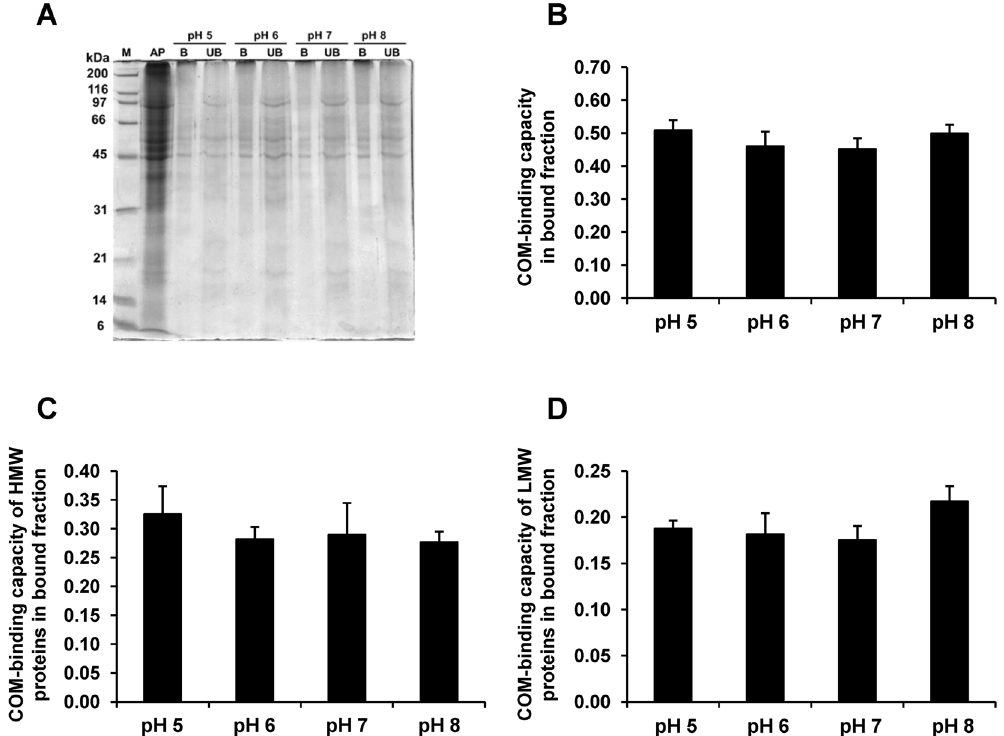
Figure 7. Effect of pH on COM-binding capacity of apical membrane proteins. Proteins isolated from apical membranes of polarized MDCK cells were incubated with plain COM crystals under varying pH conditions. ( A ) SDS-PAGE band patterns of apical membrane (AP), bound (B) and unbound (UB) fractions stained with Coomassie Brilliant Blue G-250. ( B ) COM-binding capacity of proteins in the bound fraction. ( C ) COM- binding capacity of HMW proteins (M r ≥ 45 kDa) in bound fraction. ( D ) COM-binding capacity of LMW proteins